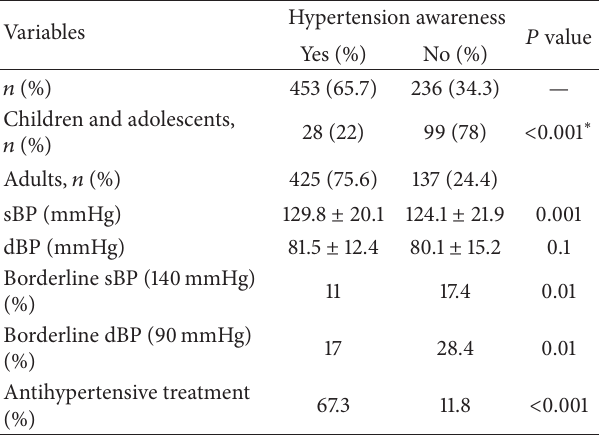
Table 3: Hypertension